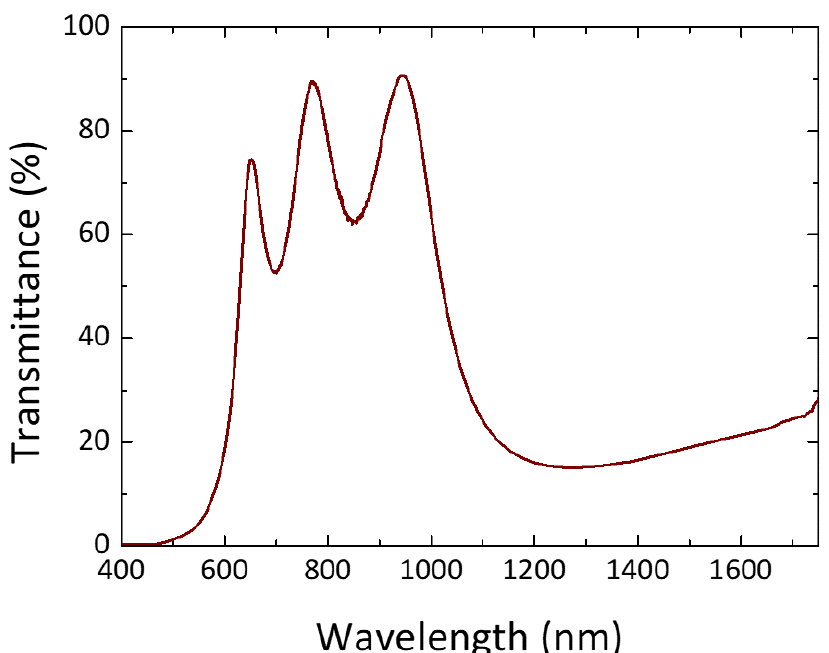
Figure 1. Transmission spectrum acquired from a glass substrate coated with a dielectric multilayer and an ITO film. A Shimadzu UV-2600 UV-Vis spectrophotometer and an Avantes AvaSpec-NIR256- 1.7-EVO spectrometer were employed in tandem to produce the spectrum spanning from 400 to 1750